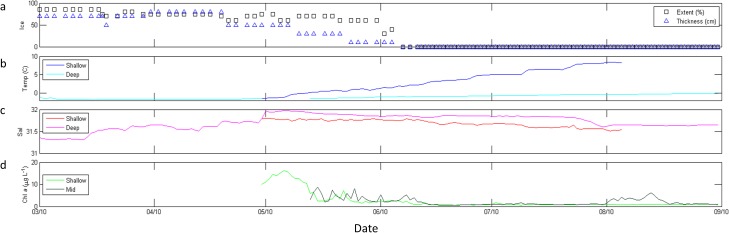
M2 data from March through August 2010.(a) ice extent (%, black boxes) and thickness (blue triangles); (b) shallow (dark blue) and deep (cyan) temperature (° C); (c) shallow (red) and deep (magenta) salinity; and (d) shallow (light green) and mid-column (dark green) Chl a fluorescence (μg L-1).